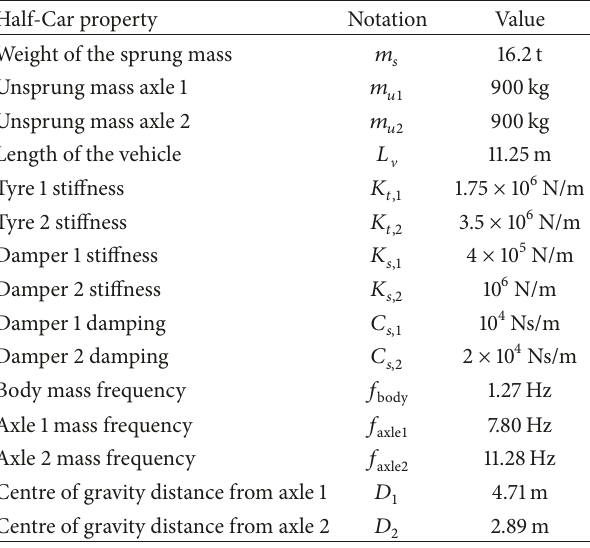
Table 1: Properties of the vehicle.